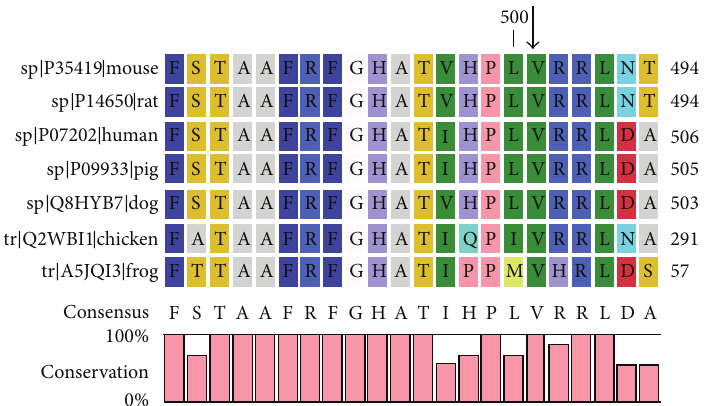
Figure 3: Multiple-sequence alignment of human TPO with those of mouse, rat, pig, dog, chicken, and frog. The alignment data show that valineatposition501ishighlyconservedamongsthumanandmanydifferentanimalspecies.Thepositionofthemutatedresidue(p.Val501Gly) is indicated by the arrow. This figure was generated using the CLC Sequence Viewer 6.5.2 algorithm.